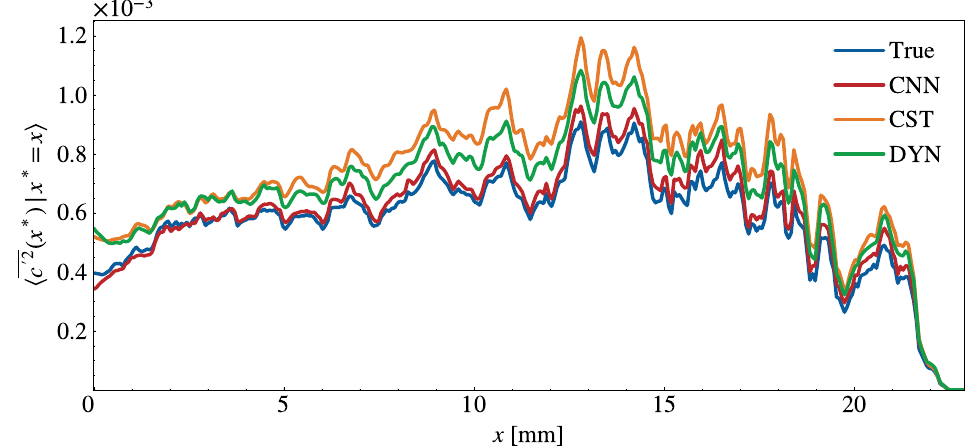
Figure 10. Evolution of transverse averages of the true c (cid:48) 2 and model predictions along the streamwise direction x